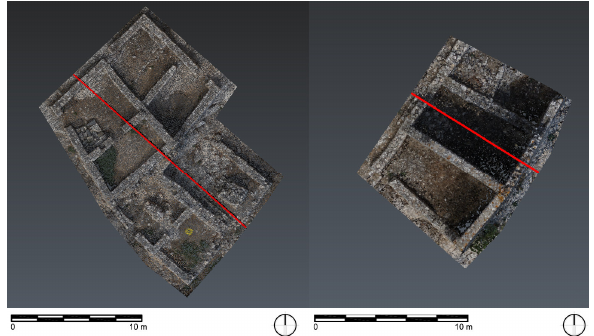
Figure 6. Position of the two sections in Sample A (left) and Sample B (right)